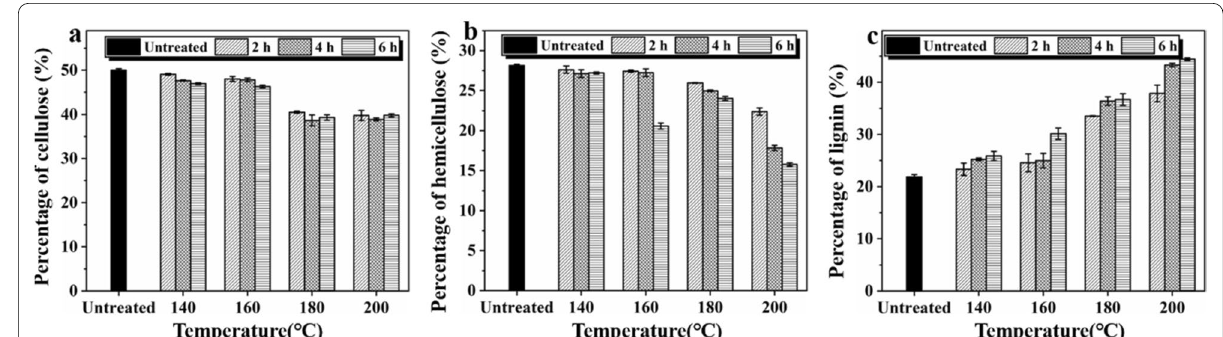
Fig. 5 The percentage of cellulose, hemicellulose and lignin of untreated sample and the treated samples at varied temperature (140, 160, 180 and 200 °C) for varied time (2, 4 and 6 h). a Cellulose, b hemicellulose, c